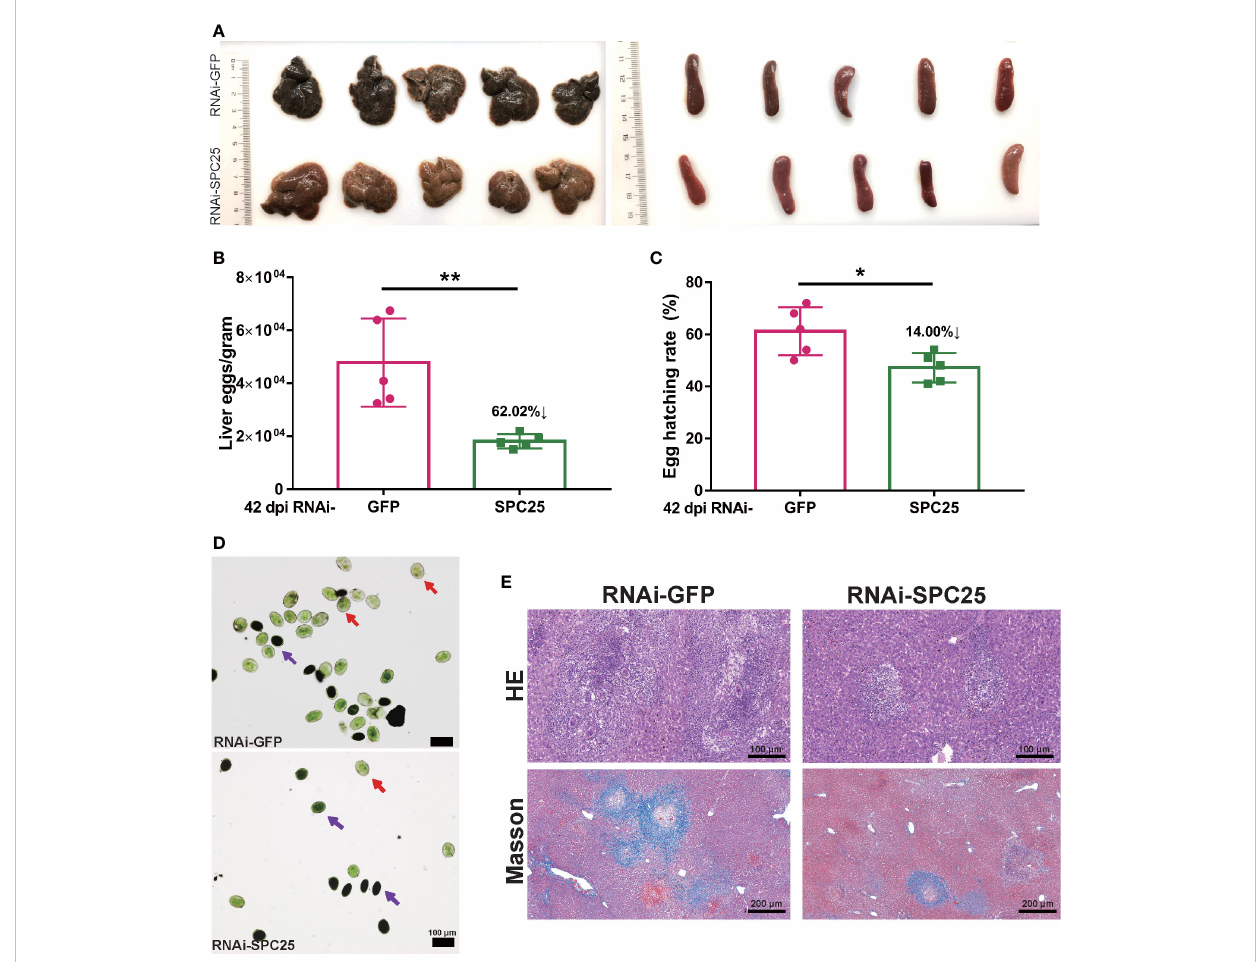
FIGURE 6 Examination of fecundity and the pathogenicity of RNAi-SPC25 worms. (A) Representative livers and spleens from the fi ve mice per experimental group. (B) Egg number of liver per gram from RNAi-GFP and RNAi-SPC25 group mice on the 42 dpi. (C) Hatching rates of the eggs from the different groups of mice liver. Each group had fi ve biological replicates, and the data were shown as means ± SEM. (D) Acridine orange staining of S. japonicum eggs. Red arrows indicated mature eggs, and purple arrows indicated immature eggs. (E) Histological assessment of mouse liver by HE and Masson staining. Each group had fi ve biological replicates, the images shown were representative experimental results of one mouse. * p < 0.05, ** p < 0.01,